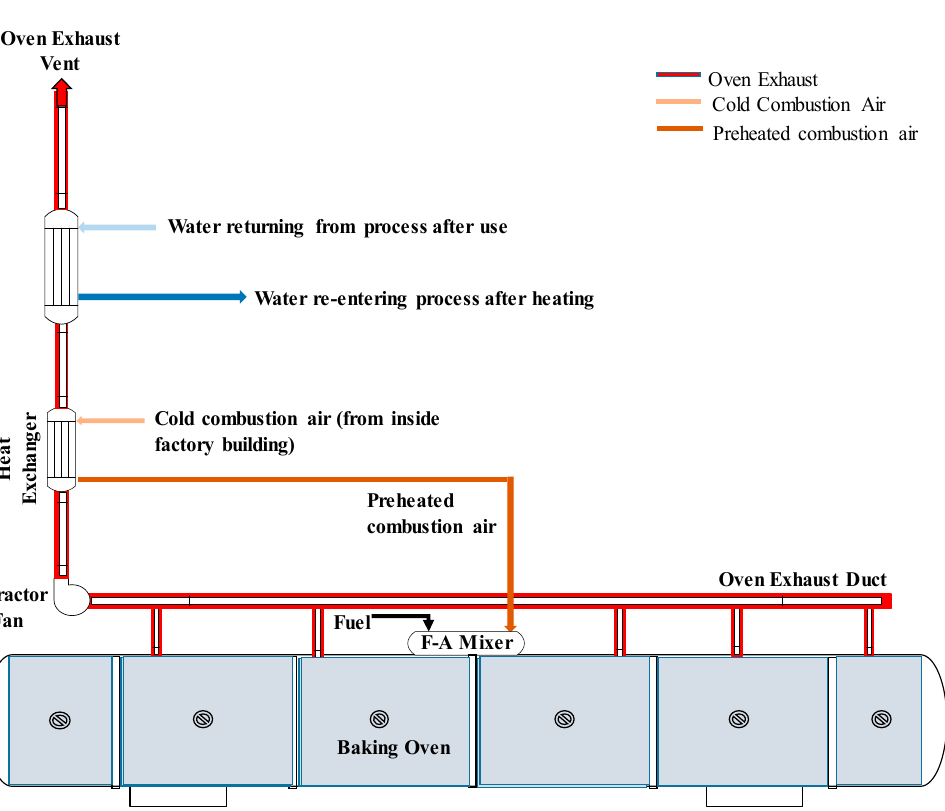
Table 9. Key performance indicators of the industrial-scale baking oven before and after heat recovery to preheat combustion air and reheat returning process water.